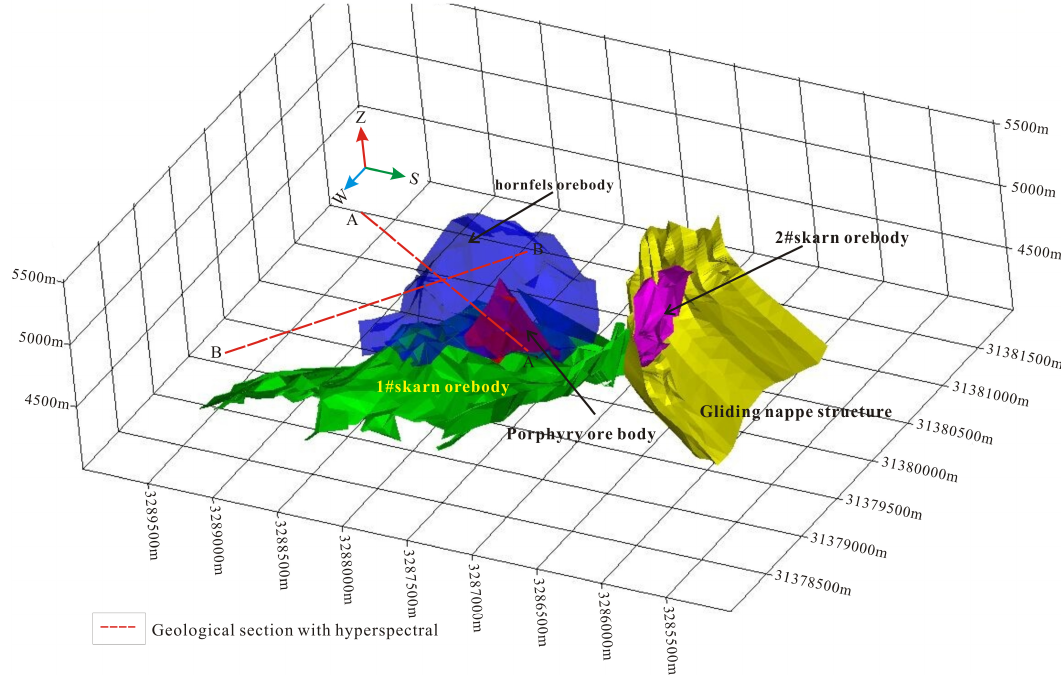
Figure 2. 3-D view of orebodies in Jiama Cu–polymetallic system, including the 1 # skarn orebody, the 2 # skarn orebody, the porphyry orebody, and the hornfels orebody (adapted from Zheng et al. [41]). The average grade of 1 # skarn orebody is approximately Cu @ 0.8%, Mo @ 0.06%, Pb + Zn @ 2.0%, Au @ 0.26g/t and Ag @ 15 g/t [45]. Cu mineralisation in the skarn